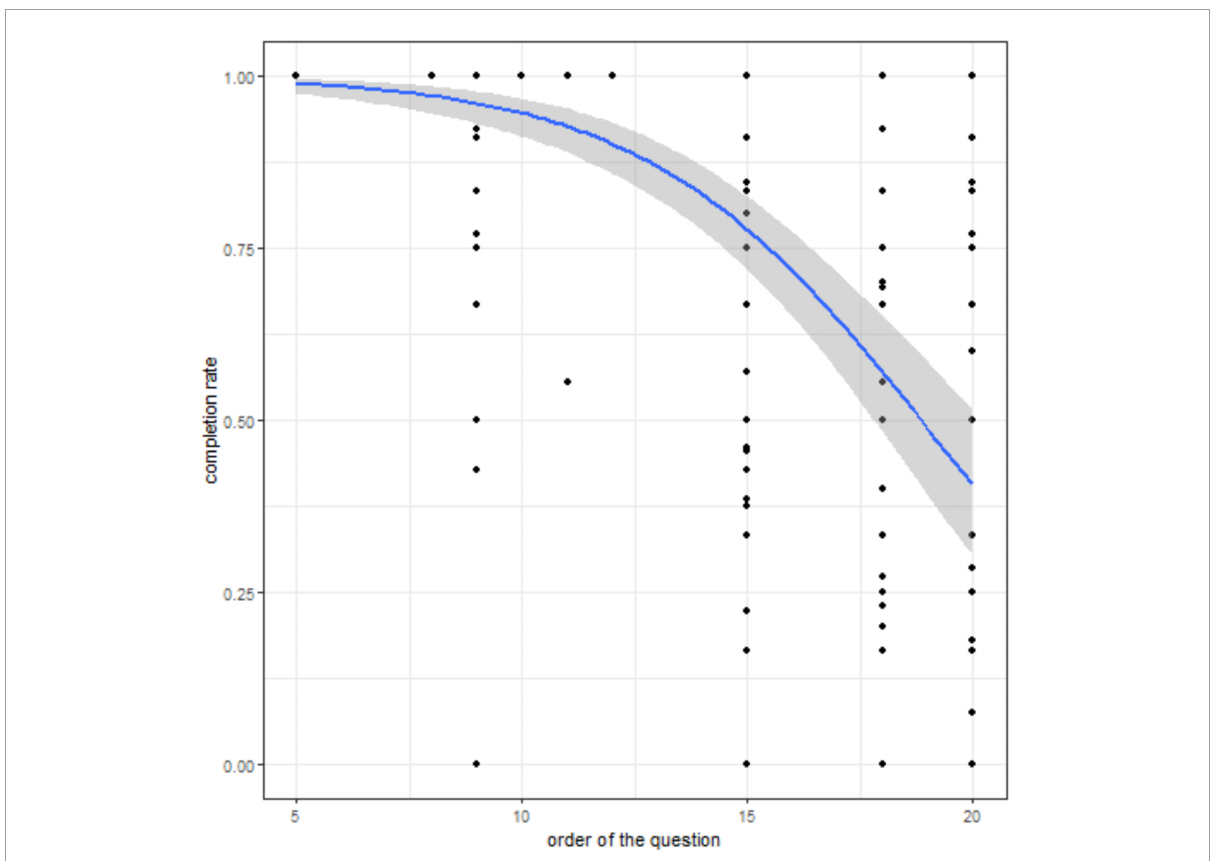
FIGURE4 Completion rate according to the question position in the daily EMA. Relationship between the question ranking in the daily EMAs and the completion rate. The predicted probability (blue curve) from the logistic mixed model and its 95% CI (shaded area) are shown. Black dots indicate the completion rate for each patient ( n = 45) and each question asked but not necessarily